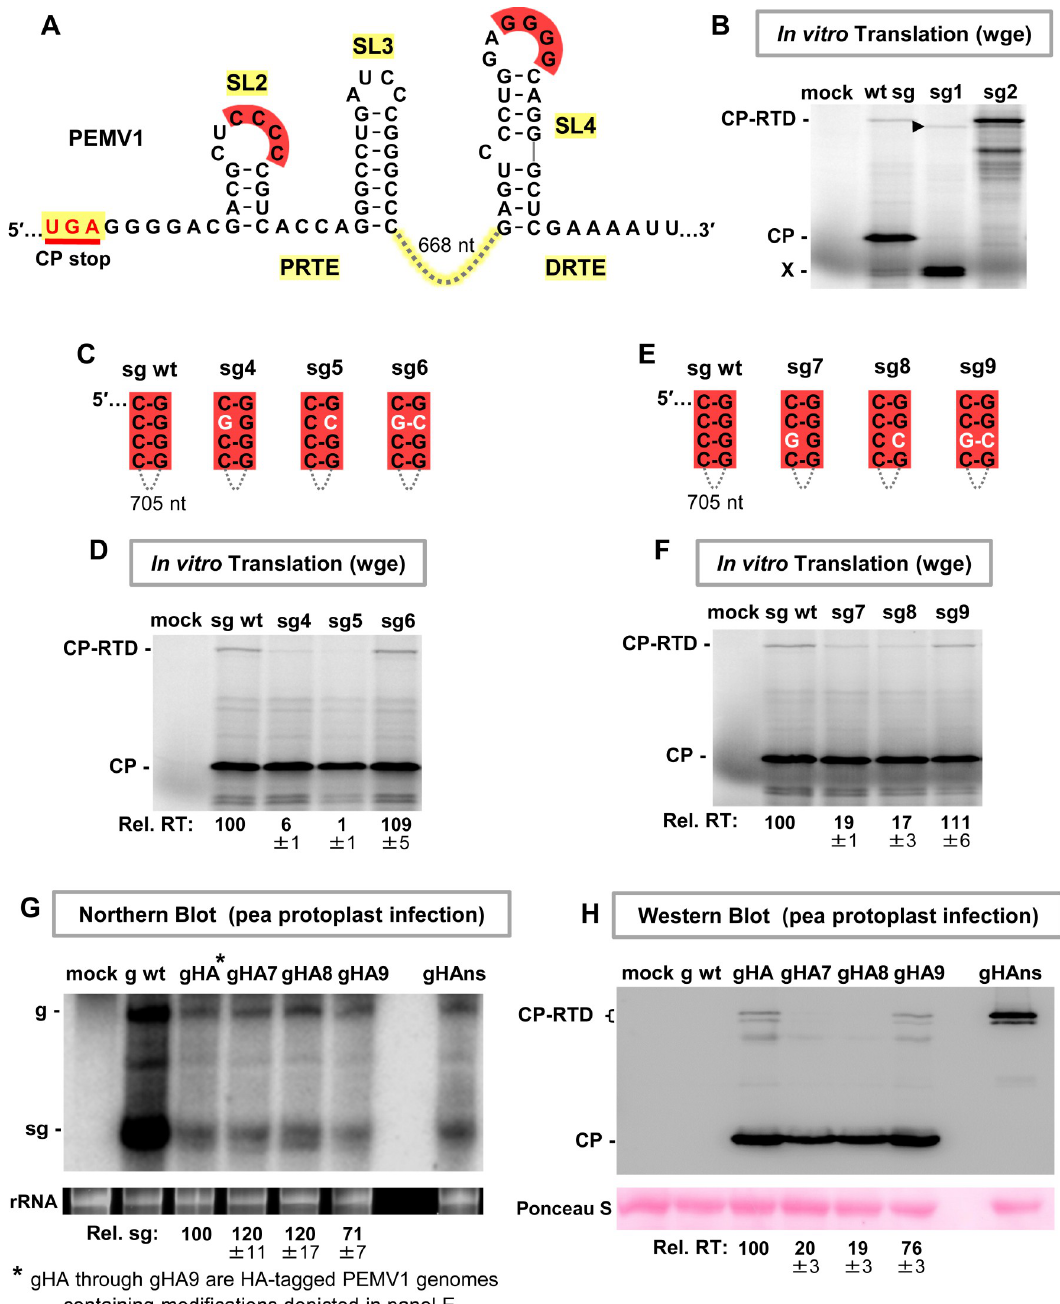
Fig 3. Assessing the red long-distance RNA-RNA interaction. (A) Secondary structures for the PRTE alternative fold and DRTE in PEMV1. The intervening 668 nucleotides between SL3 and SL4 are depicted by a connecting dashed line. (B) Wheat germ extract (wge) in vitro translation assay testing wt and mutant PEMV1 sg mRNAs. In mutants sg1 and sg2, the CP start codon and the CP stop codon, respectively, were inactivated (AUG ! CAG and UGA ! GGA). The sg mRNAs tested are indicted above each lane and the identities of the translated viral proteins are indicated on the left. The X-designated doublet band likely represents translation initiation at internal start codons in the CP ORF, and their probable readthrough products are indicated by the arrowhead. (C) and (E) Compensatory mutations introduced in the sg mRNA to test the red interaction. Nucleotide substitutions are shown in white. (D) and (F) In vitro translation analyses of the sg mRNAs shown in panels C and E, respectively. Average relative readthrough (Rel. RT) levels ( ± SE) calculated from three independent trials are shown below each lane. (G) Northern blot analysis of total nucleic acids isolated from pea protoplasts transfected with wt and HA-tagged mutant PEMV1 genomes. gHA, gHA7, gHA8, gHA9 and gHAns each contain a triple HA tag inserted 6 amino acids from the CP N-terminus. Tagged genomic mutants gHA7, gHA8 and gHA9